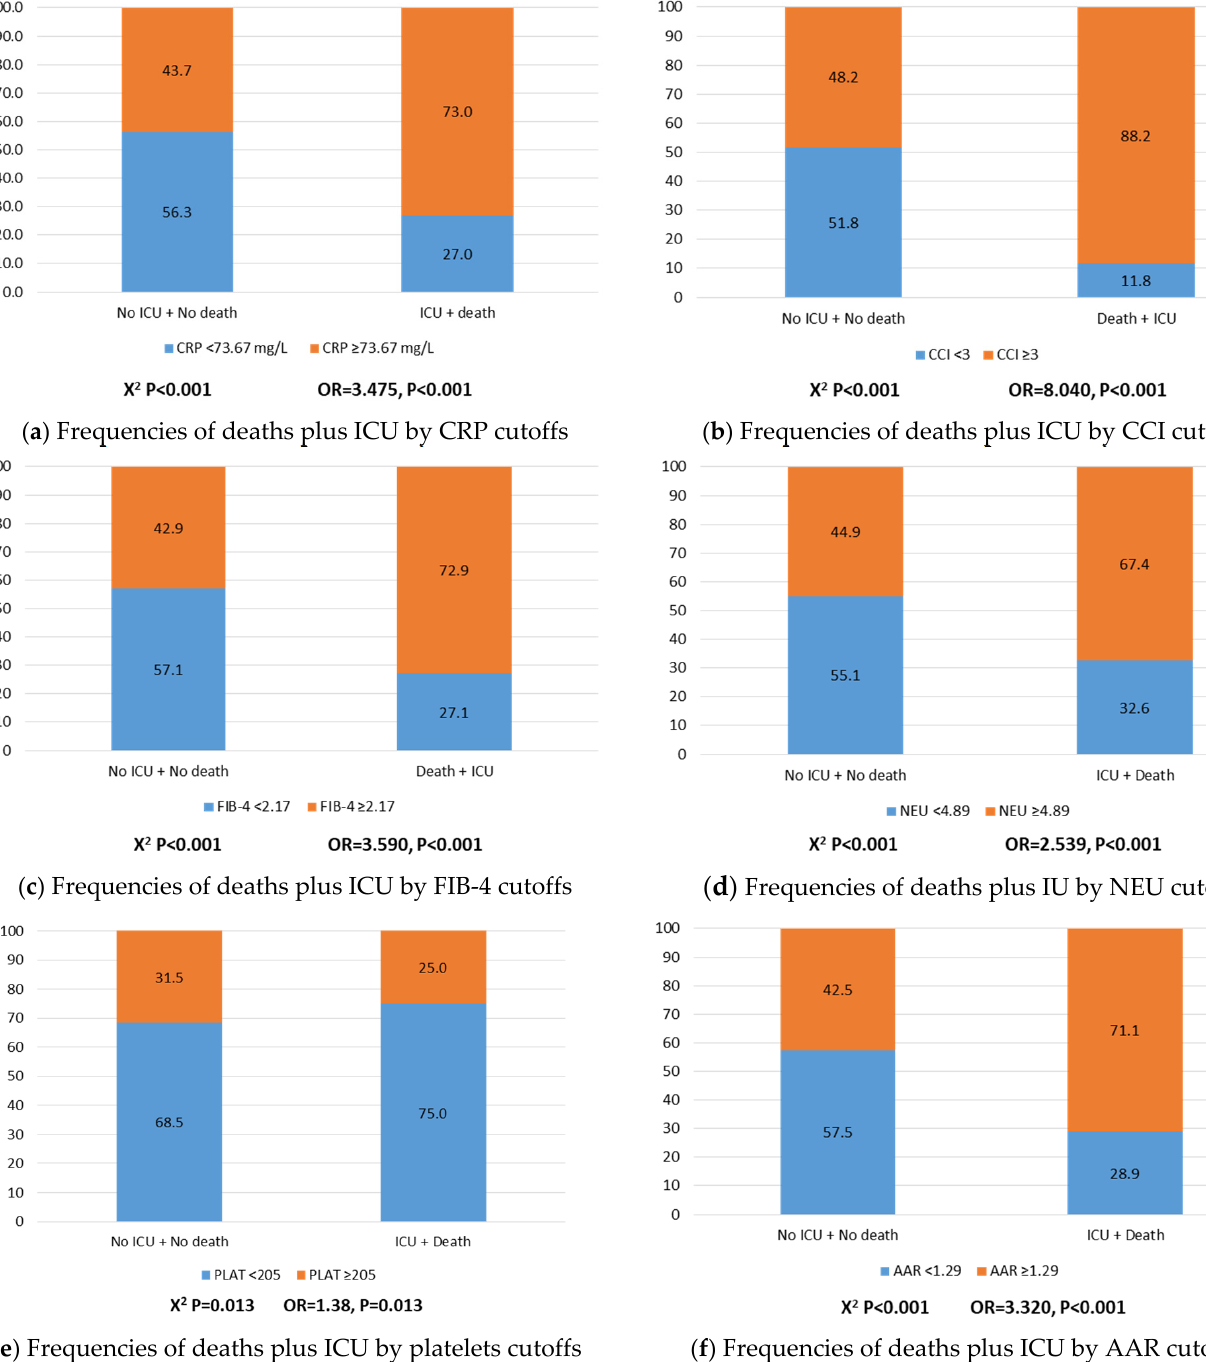
Figure 1. Frequencies and odds ratios (OR) of ICU plus death by the cutoffs (median) values of CRP, CCI index, FIB-4, neutrophils, platelets, and AAR ratio.